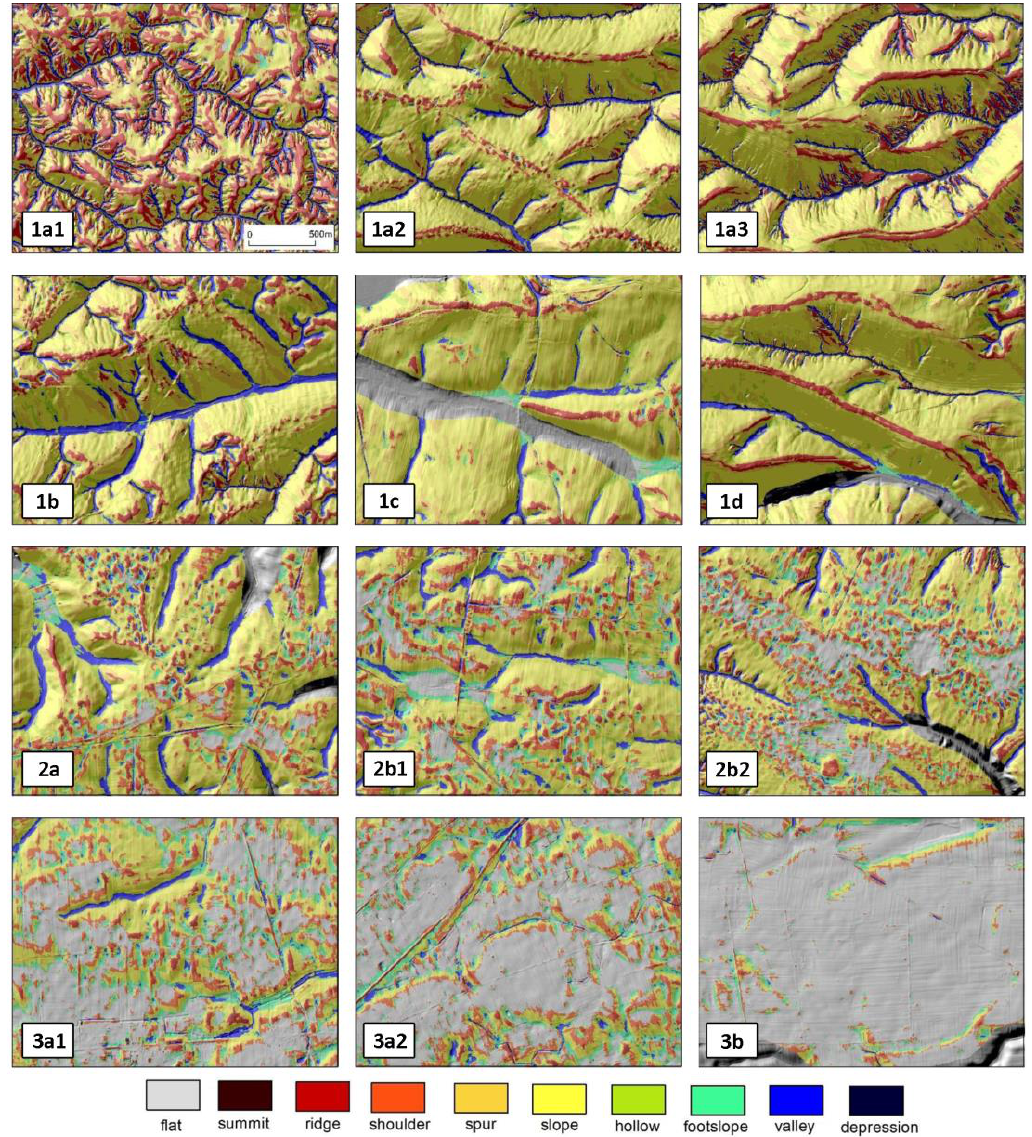
Figure 7. Example geomorphons maps of each relief subtypes. Localization of subfigures shown on Figure 1. Subfigures ( 1a1 , 1a2 ), ( 1a3 )(Ha), ( 1b )(Hb), ( 1c )(Hc) and ( 1d )(Hd) represent subtypes of type “High”; ( 2a )(Ma), ( 2b1 ) and ( 2b2 )(Mb) represent subtypes of type “Medium”; ( 3a1 ), ( 3a2 )(La) and ( 3b )(Lb) represent subtypes of type “Low”.